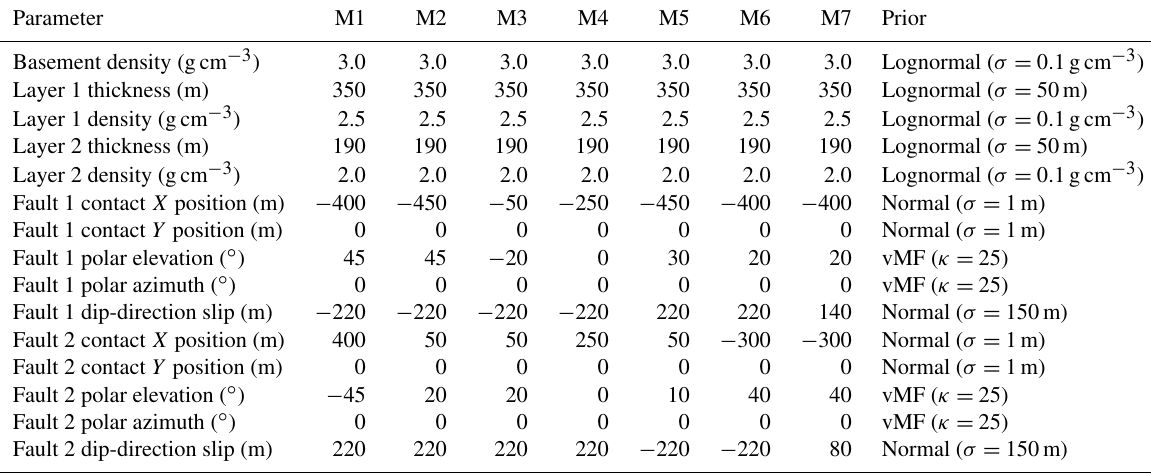
Table 2. Parameter true values and prior distributions for fault-focused kinematic models labeled M1 to M7. The prior mean is set to the true value for each parameter.